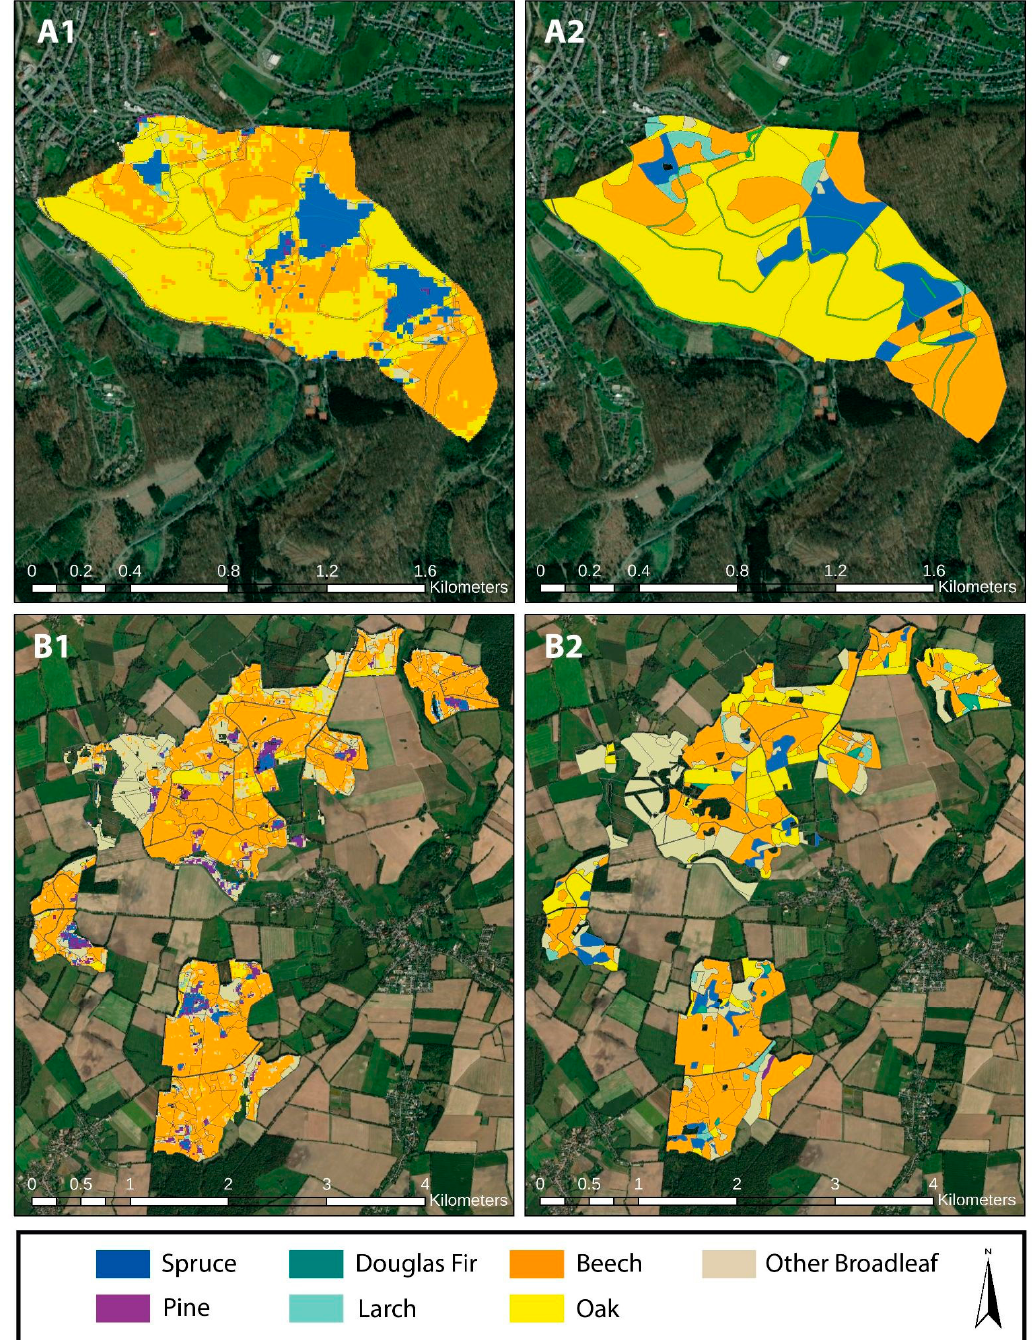
Figure 4. Dominant tree species classification ( A1 , B1 ) compared to the dominant tree species per forest management unit as recorded by the forest inventories of the forest management plans ( A2 , B2